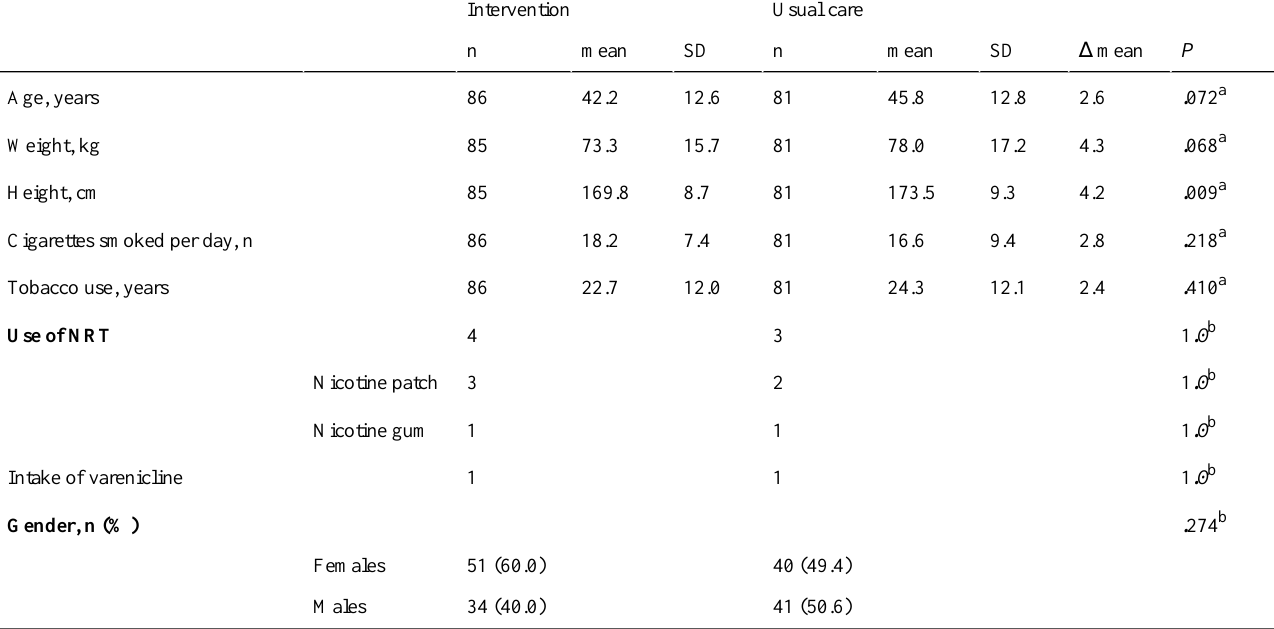
Table 1. Baseline characteristics at enrollment.